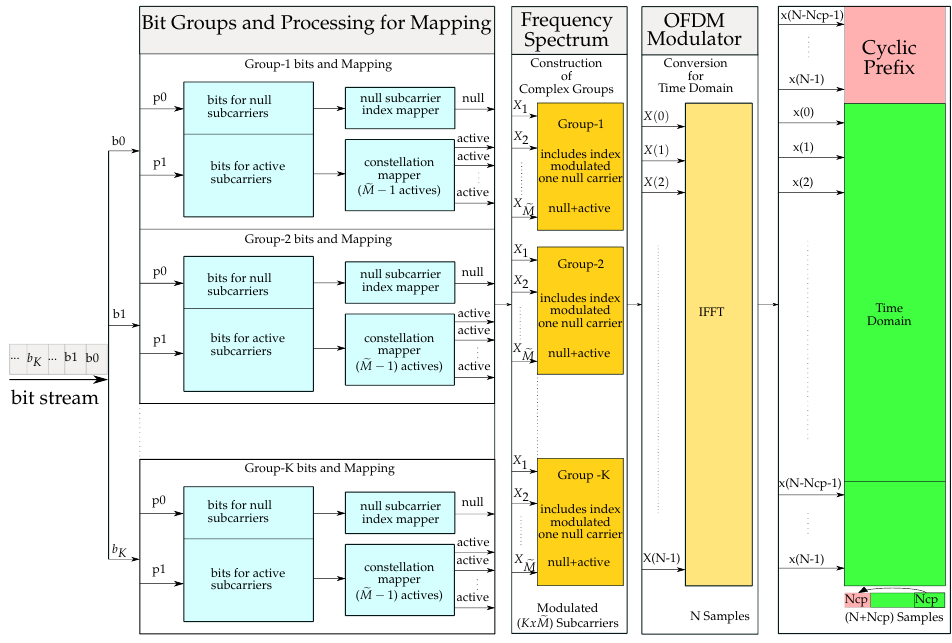
Figure 4. The proposed NSC-OFDM-IM